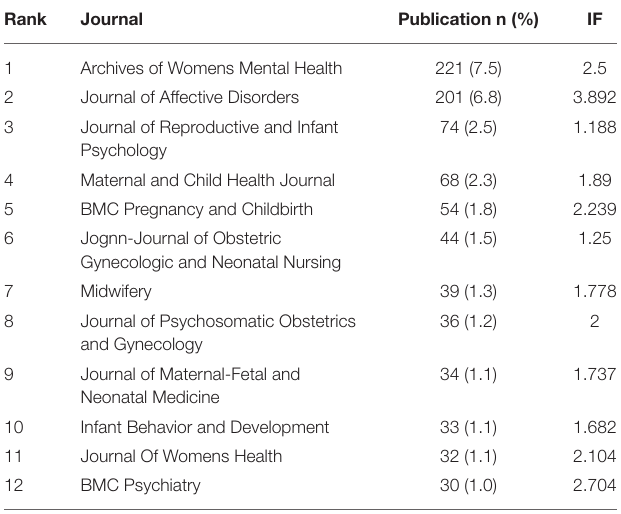
TABLE 1 | Core journals of postpartum depression research published from 2000 to 2020.